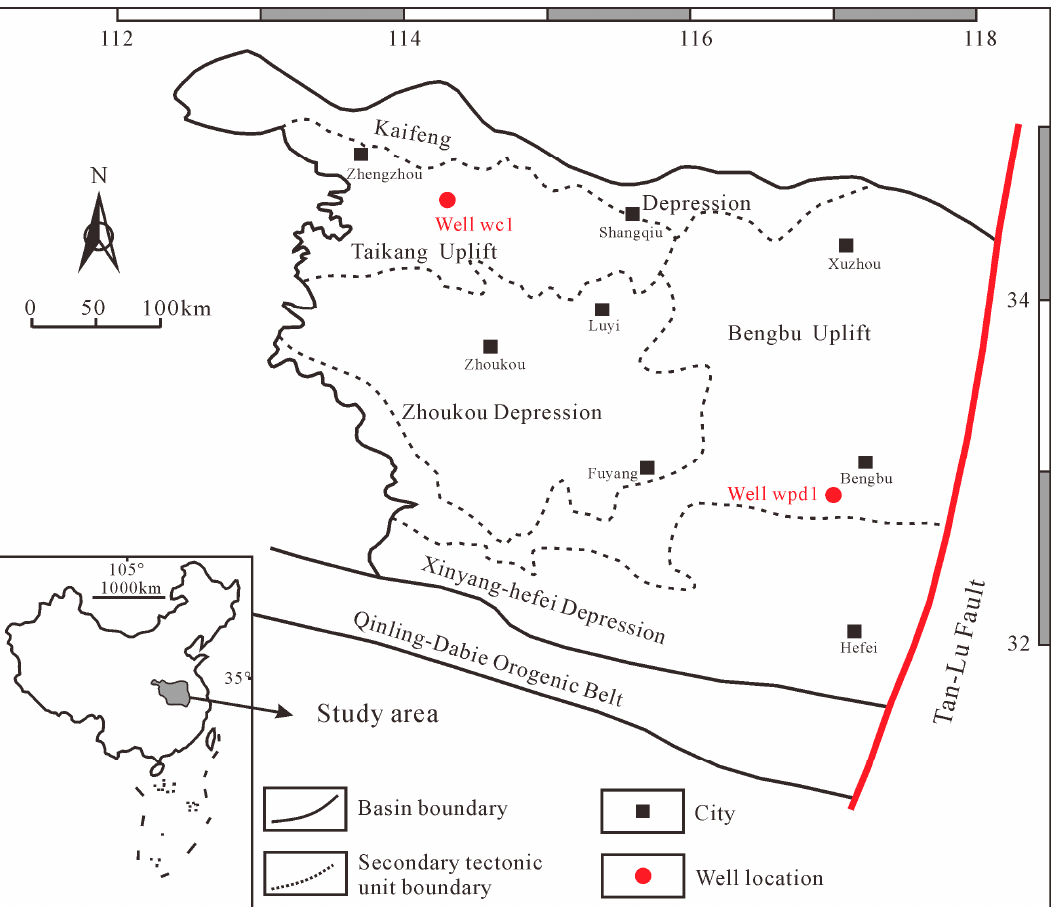
Figure 1. Tectonic geology condition of southern North China basin (SNCB) and investigated well location (adapted from [34]).